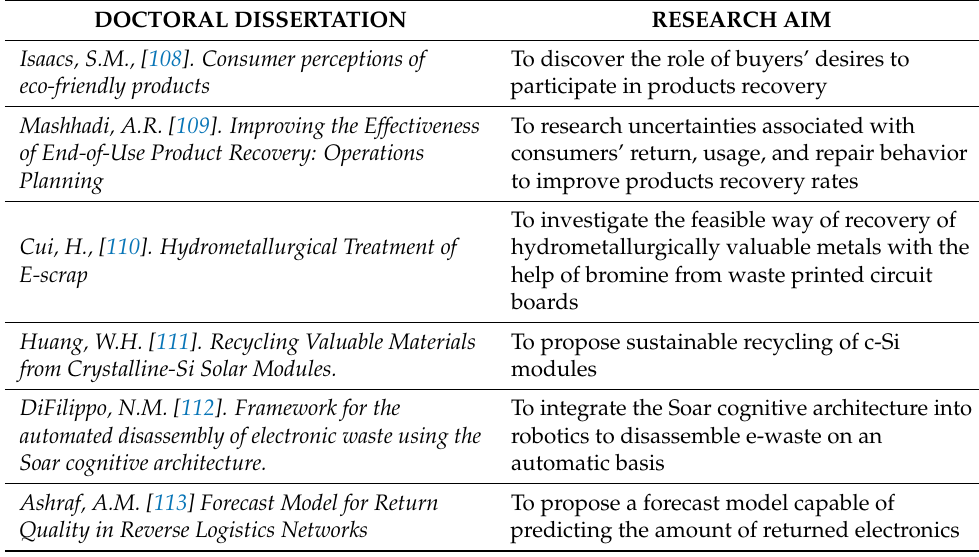
Table 4. The research aim of six e-waste doctoral dissertations.